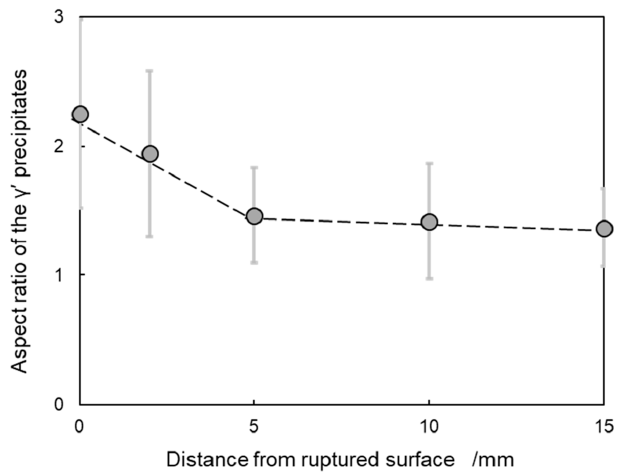
Figure 8. Relationship between the aspect ratio of the γ′ precipitates and distance from the ruptured surface. Ruptured